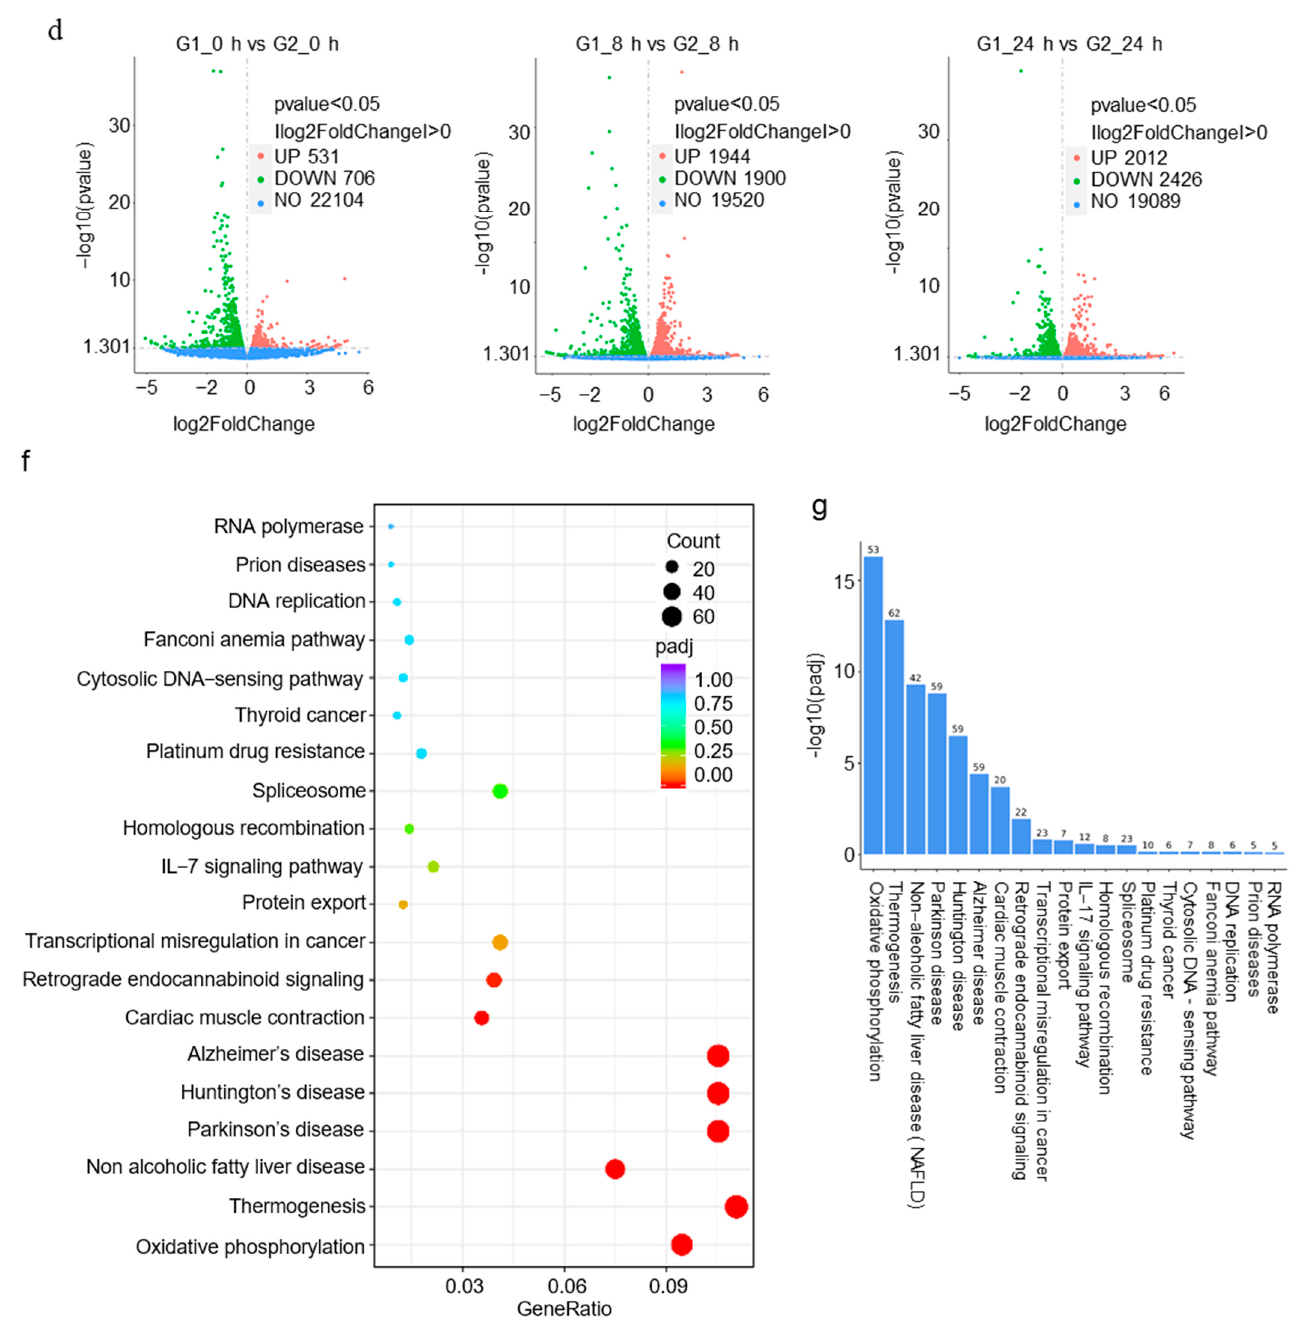
Figure 3. Transcriptomic analysis of animal-based enzymes and animal-origin-free enzymes. ( a ) Gene expression box plot. The abscissa represents different samples, the ordinate is log2 (FPKM + 1), and the box plot of each area is for five statistical measurements (from top to bottom: the maxi- mum value, the upper quartile, the median, the lower four quantile, and the minimum). This figure shows the distribution of gene expression levels in different groups of samples (three biological replicates per group). G1 represents Group 1, which comprises 37 °C animal-based enzyme detach- ment of cells at 37 °C; G2 represents Group 2, which comprises 37 °C animal-origin-free enzymes to digest cells at 37 °C; G3 represents Group 3, which comprises 4 °C animal-origin-free enzymes being used to digest cells at room temperature; 0 h, 8 h, and 24 h are the number of hours after digesting cells in the above three conditions of detachment solution; the control group represents cells de- tached at 37 °C with a 37 °C nonenzymatic detachment solution. ( b ) A heatmap of correlations be- tween the samples. The horizontal and vertical coordinates represent different samples. R2 repre- sents the correlation between two samples, and the closer R2 is to 1, the stronger the correlation. ( c ) Venn diagram of gene co-expression between samples. ( Top left ) G1 represents Group 1, which means that Vero cells were detached with animal-based enzymes at 37 °C 0 h, 8 h, and 24 h after digesting the cells; the control group represents cells detached with a 37 °C nonenzyme detachment solution at 37 °C. ( Top right ) G2 represents Group 2, and Vero cells were detached at 37 °C with animal-origin-free enzymes at 37 °C. ( Bottom left ) G3 represents Group 3, and Vero cells were de- tached with 4 °C animal-origin-free enzymes at room temperature. ( Bottom right ) Venn diagram of the co-expression of G1_0h, G2_0h, G3_0h, and the control group. ( d ) Volcano plot of differential gene expression at 0 h, 8 h, and 24 h (from left to right) after the cells were detached with animal- based enzymes and animal-origin-free enzymes at 37 °C. G1 represents Group 1, which comprises 37 °C animal-based enzymes that detached Vero cells at 37 °C; G2 represents Group 2, which com- prises 37 °C animal-origin-free enzymes used to digest Vero cells at 37 °C; 0 h, 8 h, and 24 h are the detachment solutions using the above two conditions a certain number of hours after the detach- ment of cells. Red represents genes upregulated in the animal-based enzymes group compared with animal-origin-free enzymes; green represents genes downregulated in the animal-based enzymes group compared with animal-origin-free enzymes; blue represents genes with no significant differ- ence between the two groups. ( e ) Cluster heatmap. The horizontal axis represents the sample name